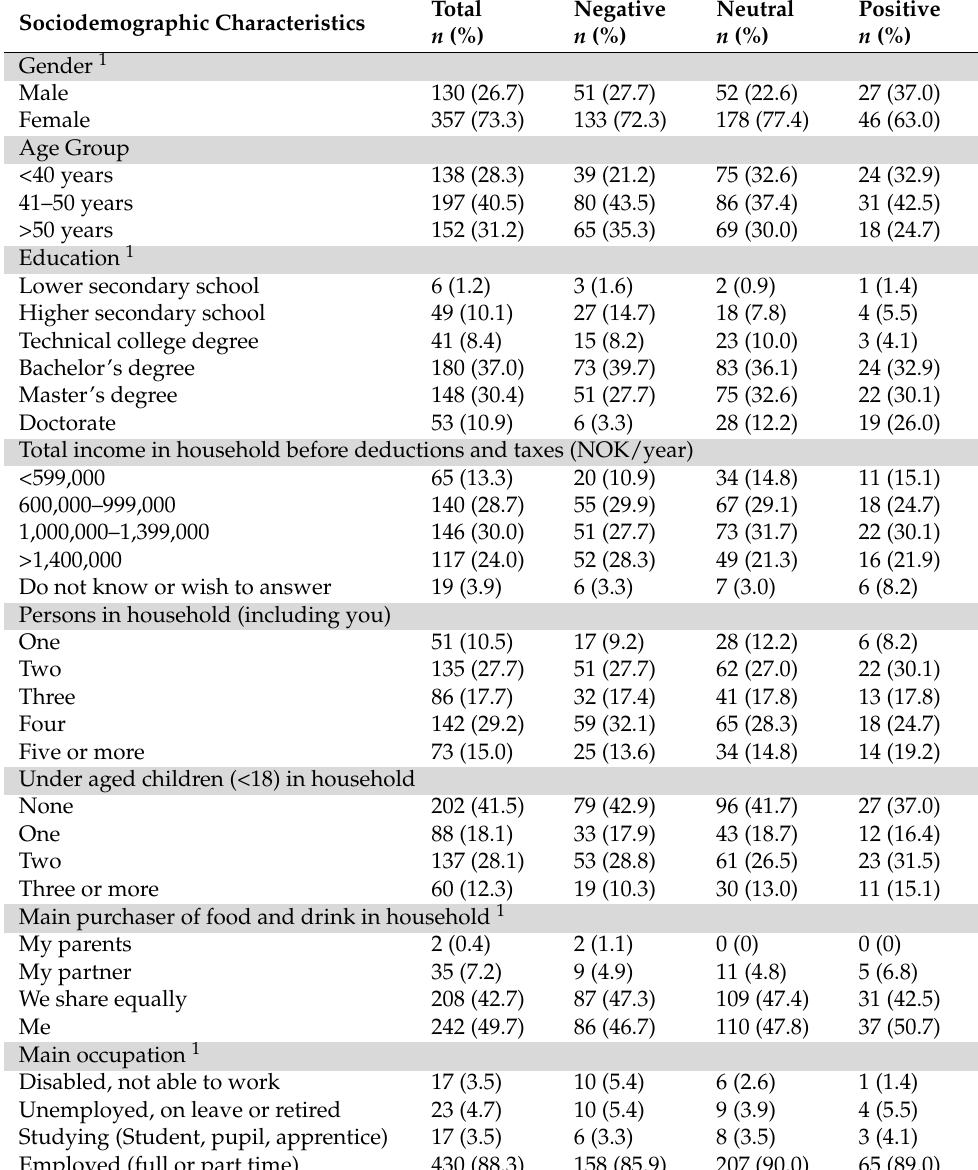
Table 4. Sociodemographic characteristics, in total and per attitudinal group, of the participants in the digital questionnaire ( n =